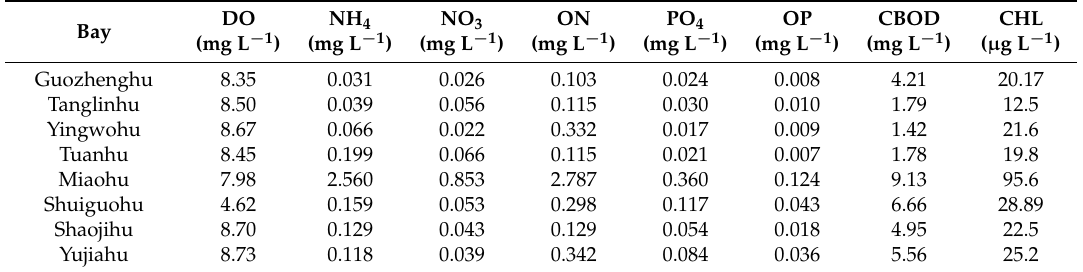
Table 1. Initial values of the water quality variables in the bays of Lake